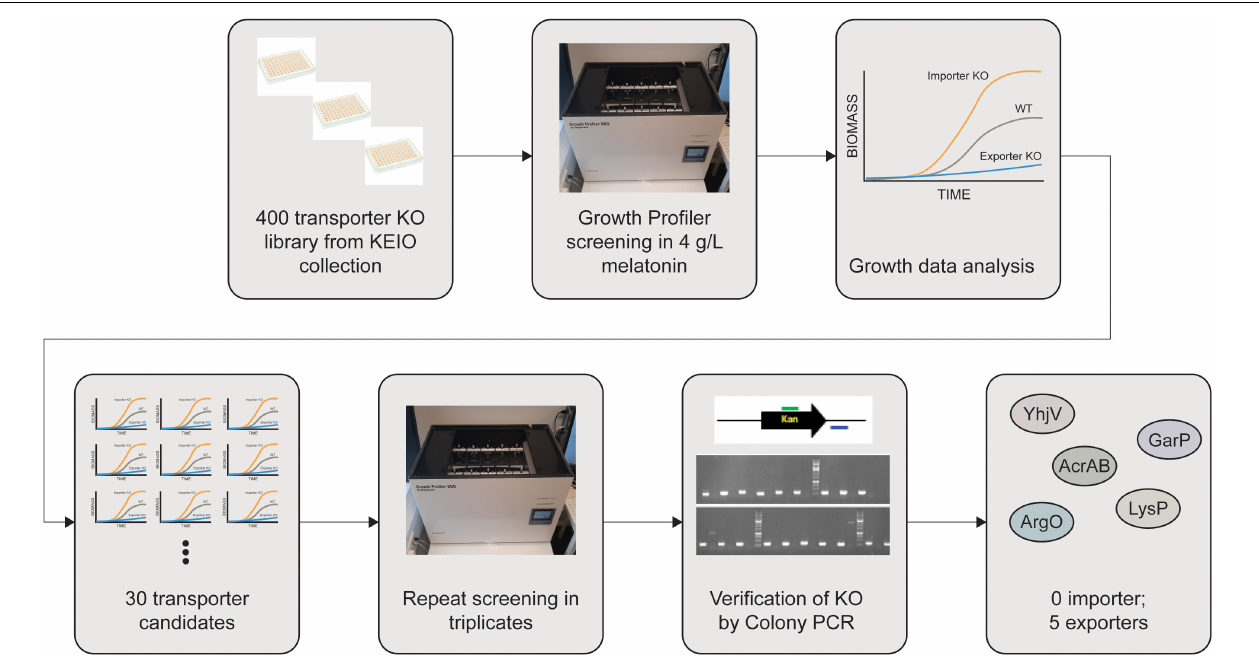
FIGURE 3 | Workflow for identification of melatonin transporters. About 400 Keio knockouts with transporter genes deleted were screened in the presence of high concentrations ( > 2 g/L) of melatonin. Gene deletions were further confirmed using colony PCR. Five knockouts giving rise to decreased melatonin tolerance are considered to play major roles in melatonin